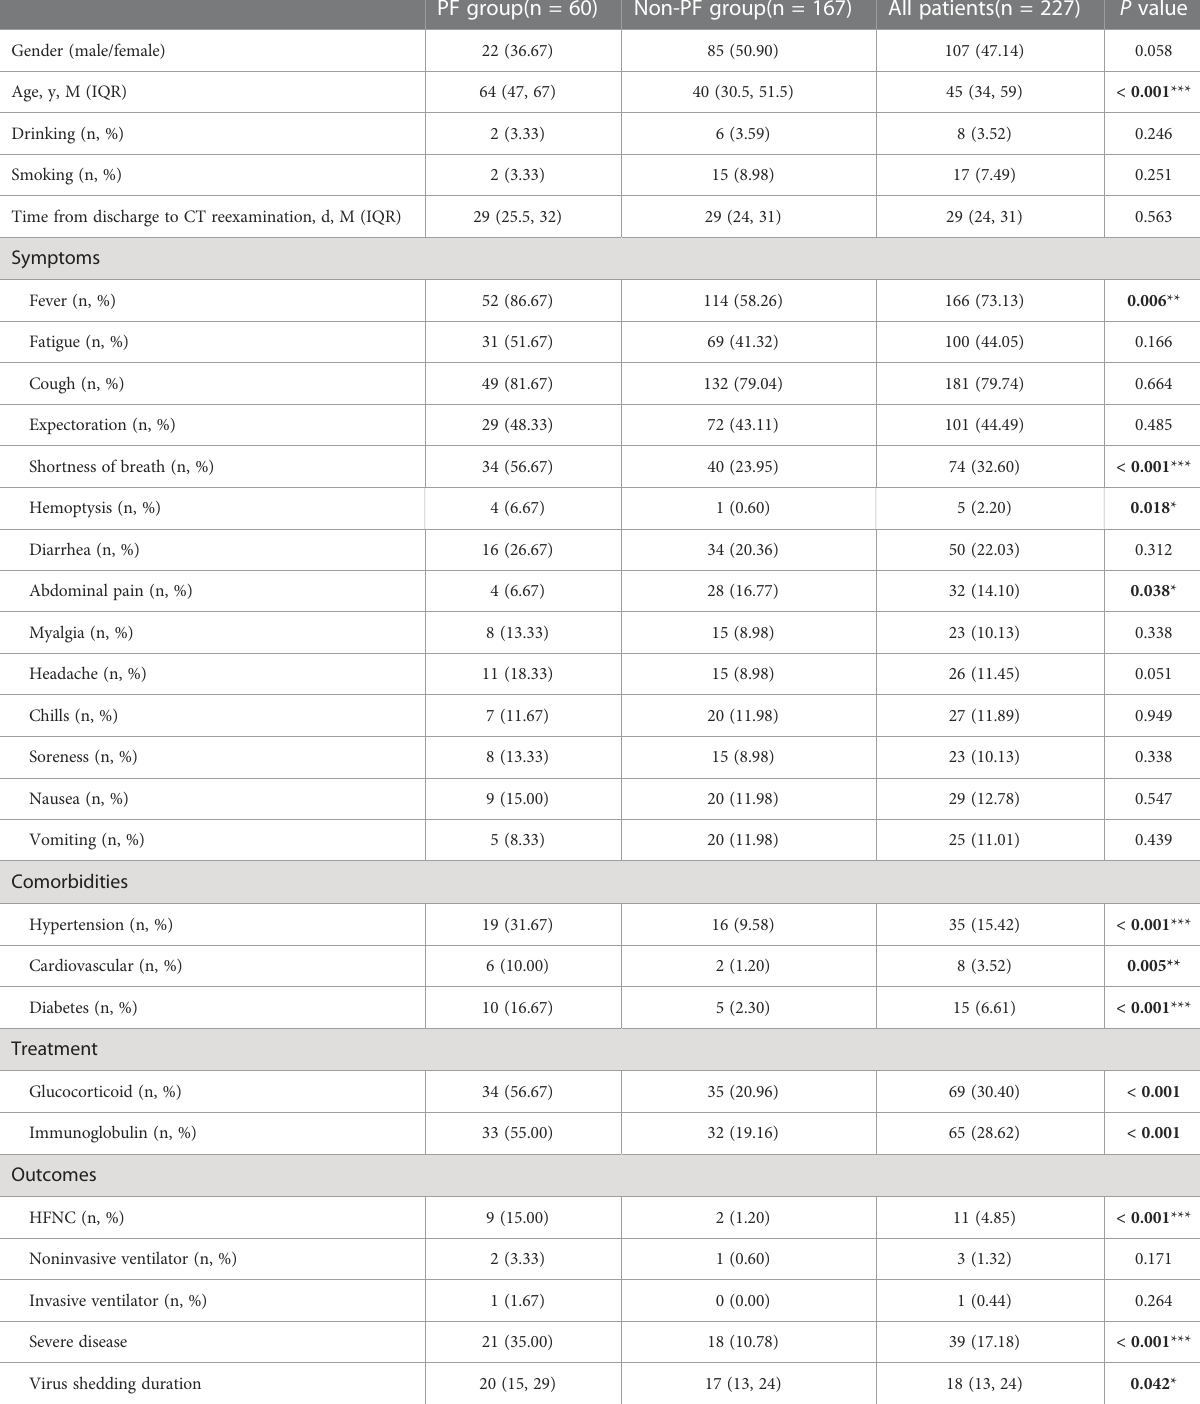
TABLE 1 Baseline characteristics of patients with or without pulmonary fi